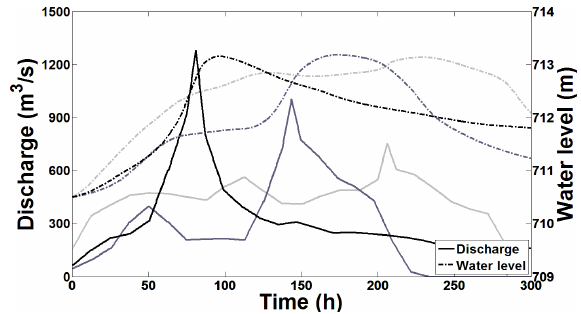
Fig. 8. Example of three DFH that yield the same maximum reser- voir level of 713.13m, which is the level for a return period of 500 years in the Buend´ıa reservoir.